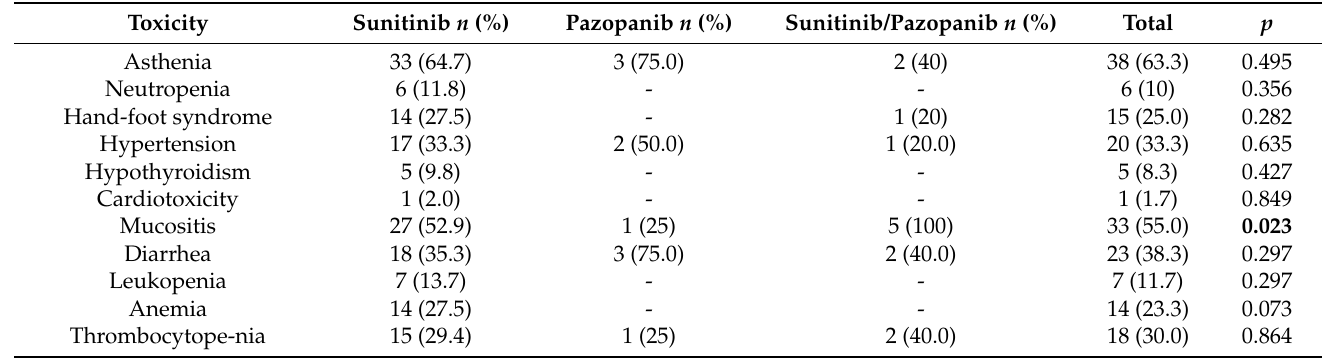
Table 2. Summary of toxicity